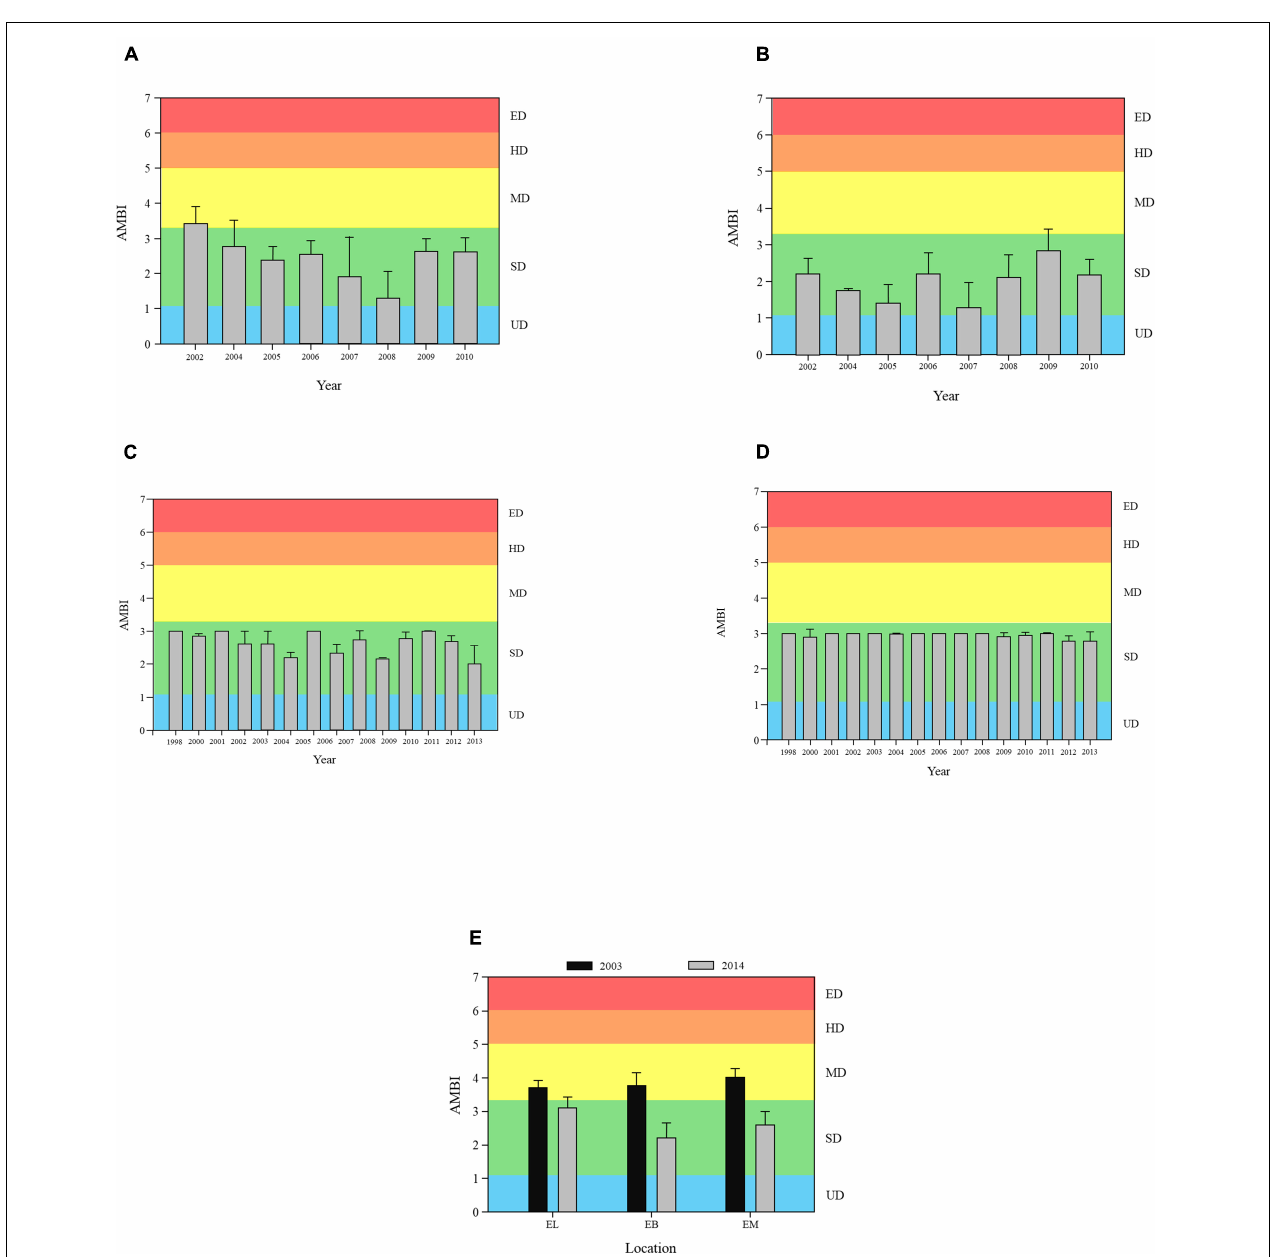
FIGURE 2 | Annual AMBI index results (mean and standard error) for (A) Porto Buxo (PB); (B) Portinho da Costa (PC); (C) Parque das Nações Subtidal (PNS); (D) Parque das Nações Intertidal (PNI), and (E) Estuary Lower (EL), Estuary Bays (EB), and Estuary Middle (EM). UD, undisturbed; SD, slightly disturbed; MD, moderately disturbed; HD, heavily disturbed, and ED, extremely